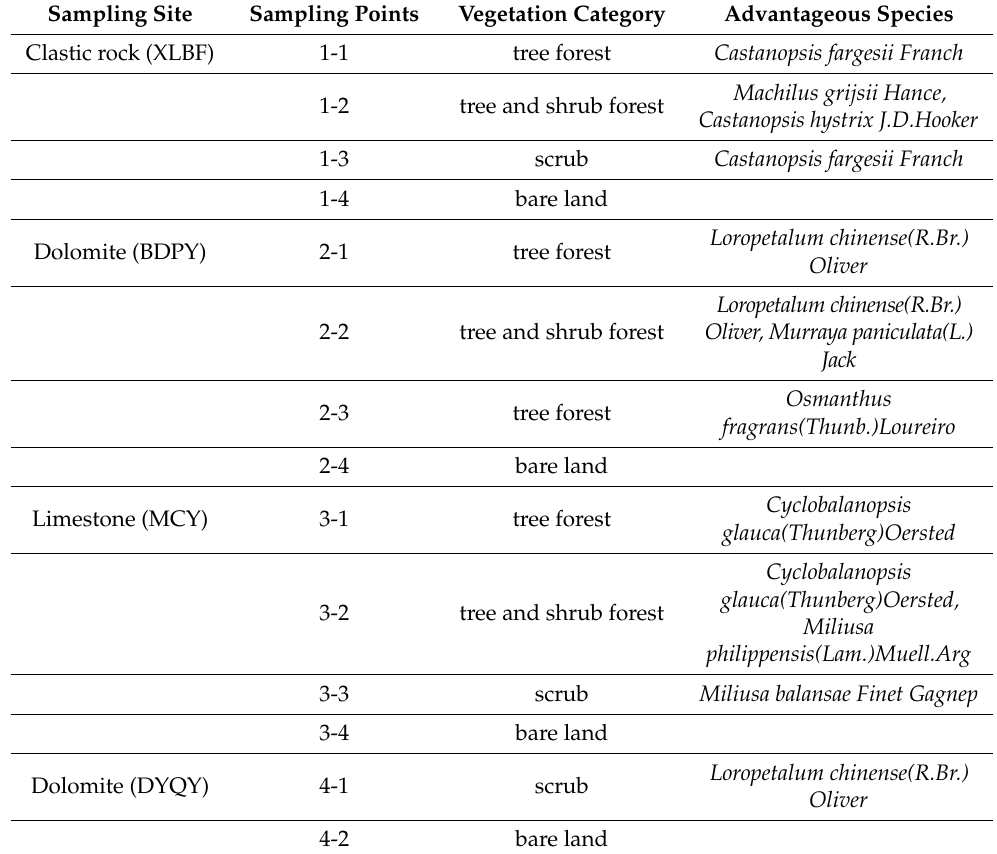
Table 1. Sampling site